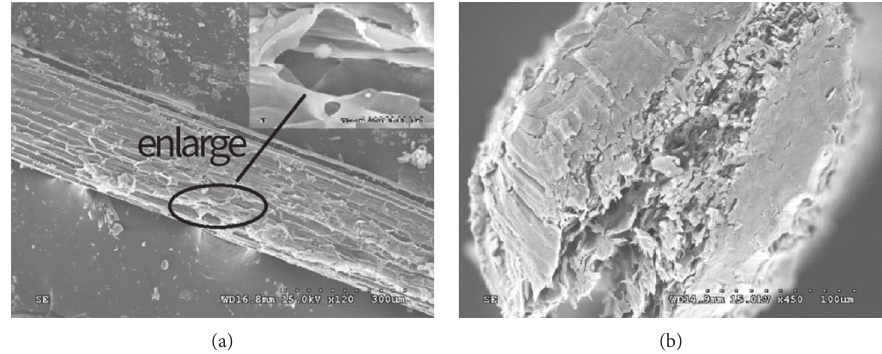
Figure 16: Cavities in the mortar created by too many